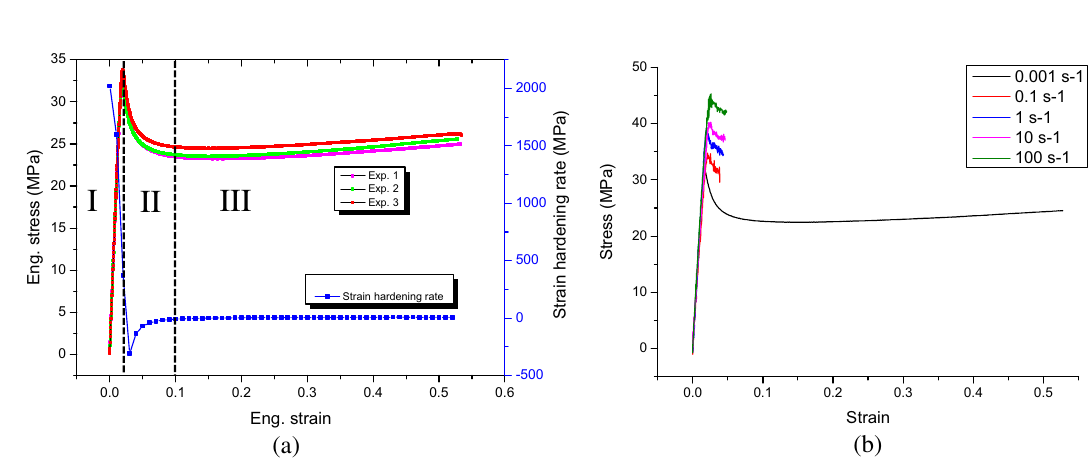
Figure 4. ( a ) Static stress–strain and strain hardening curves and ( b ) Stress–strain curves at strain rate range of 0.001 to 100 s −1